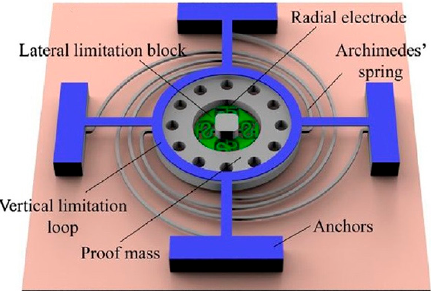
Figure 3. An omni-directional switch with four radial fixed electrodes for the detection of acceleration from any radial directions in the XOY plane [16].